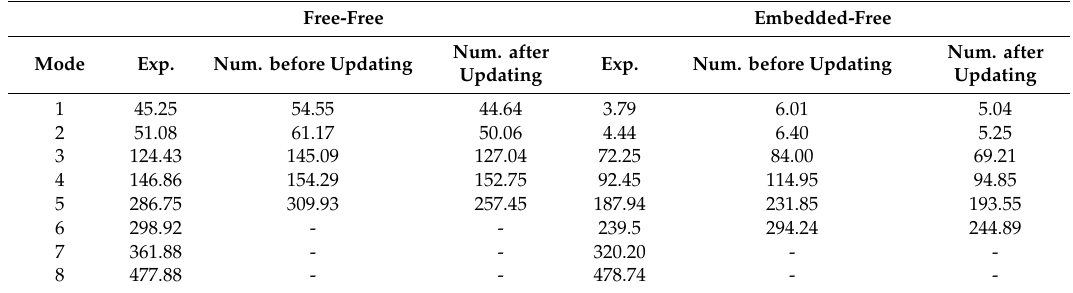
Figure 5. MAC (Modal Assurance Criterion) matrices computed for identified and numerical eigenmodes after updating in ( a ) free-free and ( b ) fixed-free boundary conditions. Table 4. Experimental and numerical modal frequencies (Hz) before and after updating